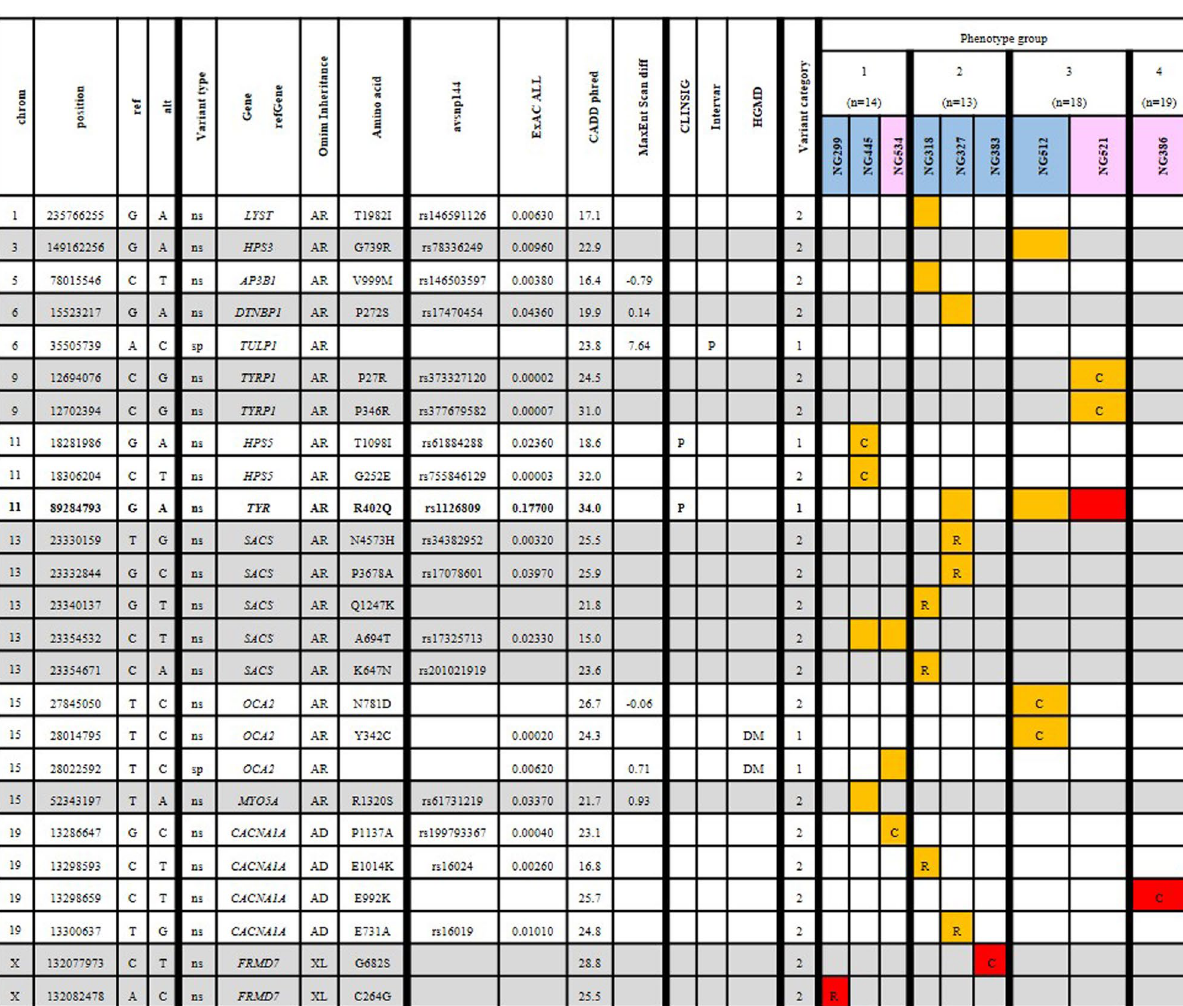
groups 1 and 2 had similar diagnostic rates of 38% and 40% respectively. Groups 3 and 4 had a 50.0% and 57.1% diagnostic rate respectively. This shows that the additional phenotyping, beyond that of the baseline examinations prior to patient selection, did not significantly increase diagnostic yield.